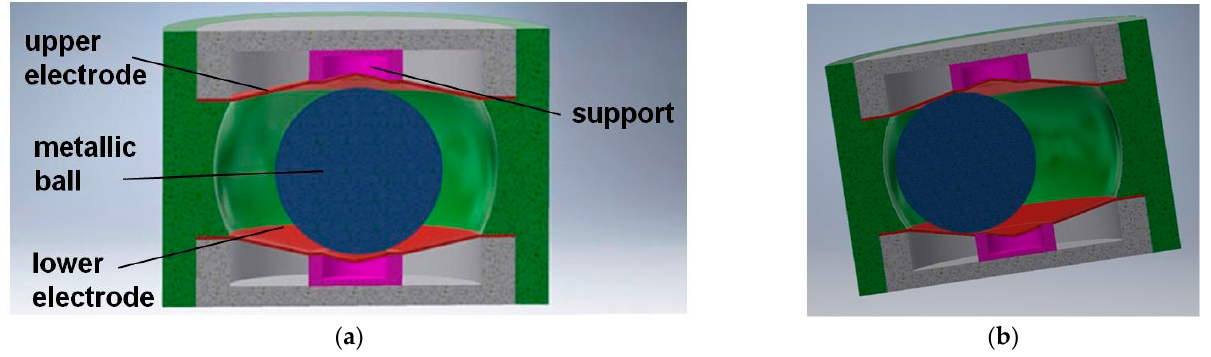
Figure 6. Dual-axis tilt switch with flexible electrodes: ( a ) the structure; ( b ) principle of